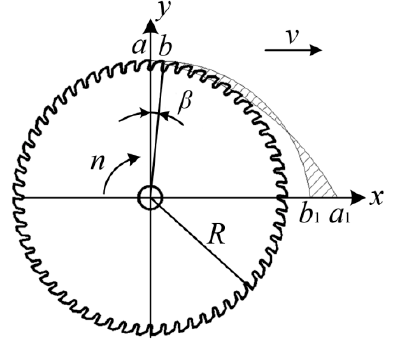
Figure 4. Path of cutter motion.